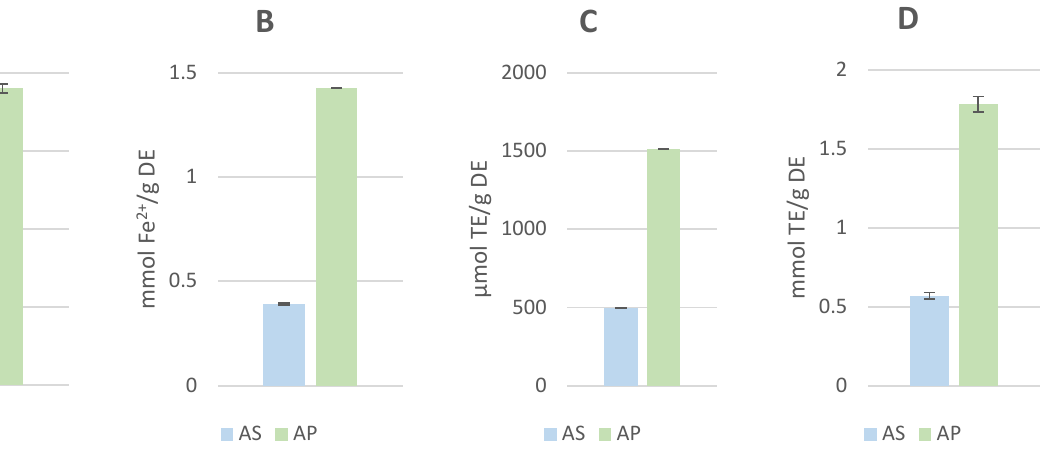
Figure 1. Quantification and antioxidant evaluation of avocado seed (AS) and peel (AP). ( A ) TPC, ( B ) FRAP, ( C ) TEAC and ( D ) ORAC.